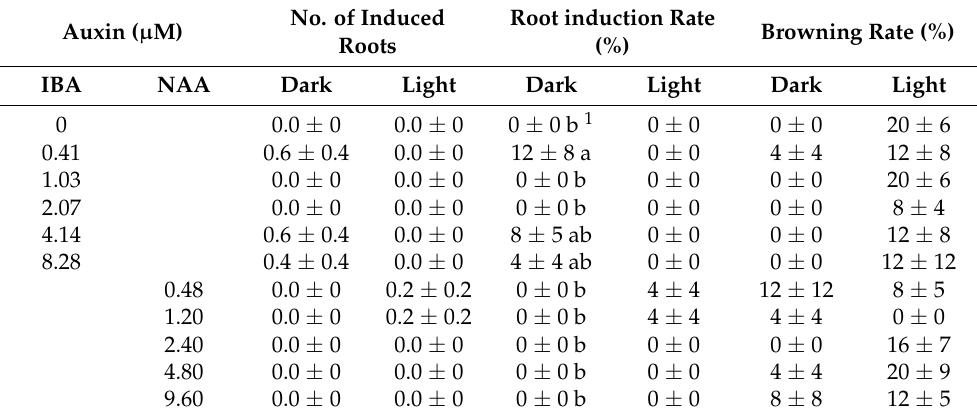
Table 7. Effect of indole-3-butyric acid (IBA) and 1-naphthaleneacetic acid (NAA) on the root induction from strawberry ( Fragaria vesca ) shoot explants after 8 weeks of culturing. No. of Induced Auxin ( µ M) Roots